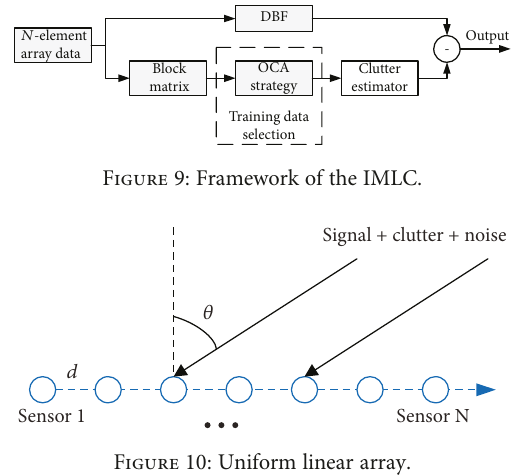
Figure 10: Uniform linear array.